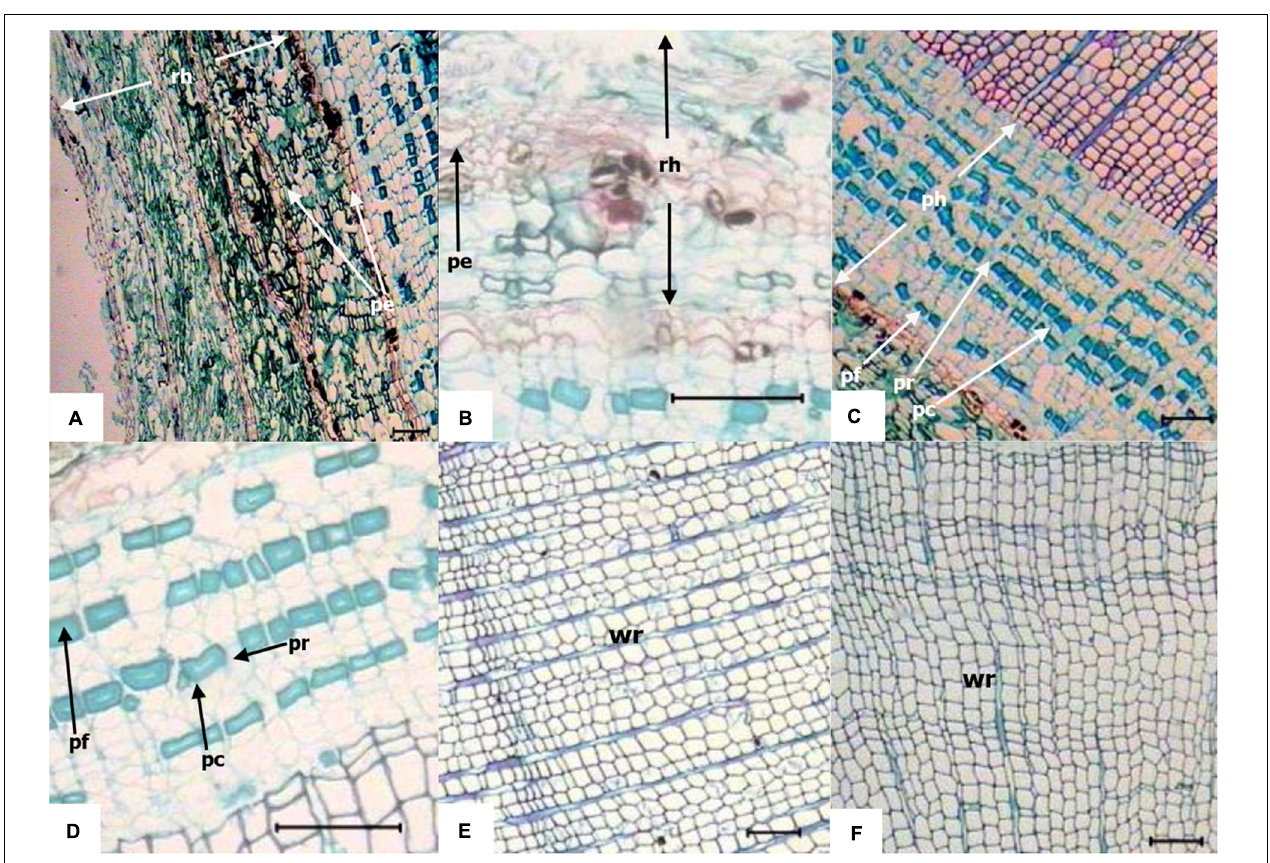
FIGURE 7 | Transverse anatomical structure of knee roots and underground roots. Horizontal line = 100 µ m. (A) Rhytidome at the apex of the knee roots (middle stage); (B) rhytidome of mid-sized underground roots; (C) phloem at the apex of the knee roots (middle stage); (D) phloem of mid-sized underground roots; (E) xylem at the apex of the knee roots (middle stage); (F) xylem of mid-sized underground roots; rh, rhytidome; pe, periderm; ph, phloem; pr, phloem ray; pf, phloem fiber; pc, phloem parenchyma cell; wr, wood ray.